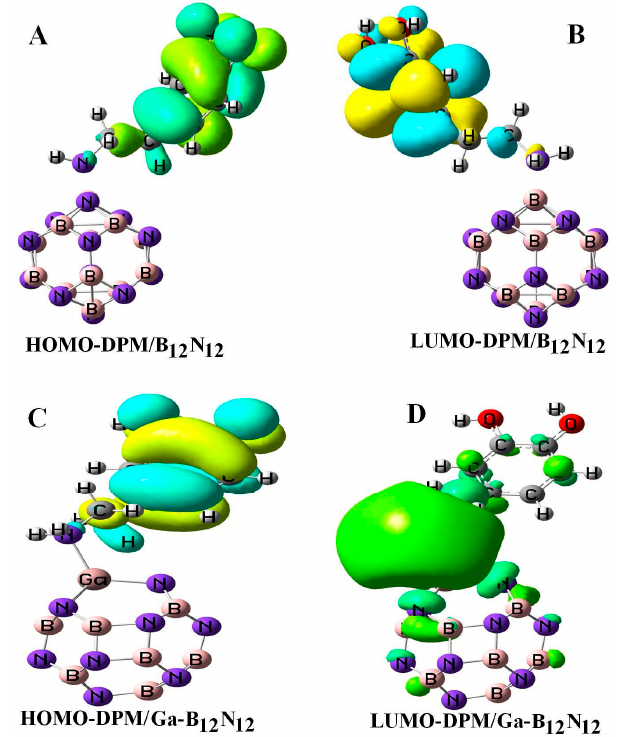
Figure 4. HOMO and LUMO orbitals of DPM over the pure ( A, B ) and Ga-doped ( C, D ) B 12 N 12 nano-cages. Figure 4. HOMOandLUMOorbitalsofDPMoverthepure( A,B )andGa-doped( C,D )B 12 N 12